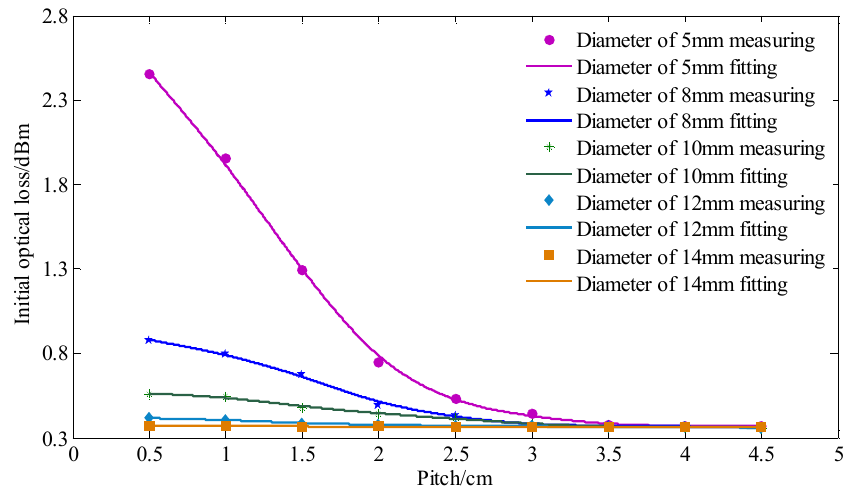
Figure 9. Influence of pitch and diameter on initial optical loss of rod-fiber coupling structure.